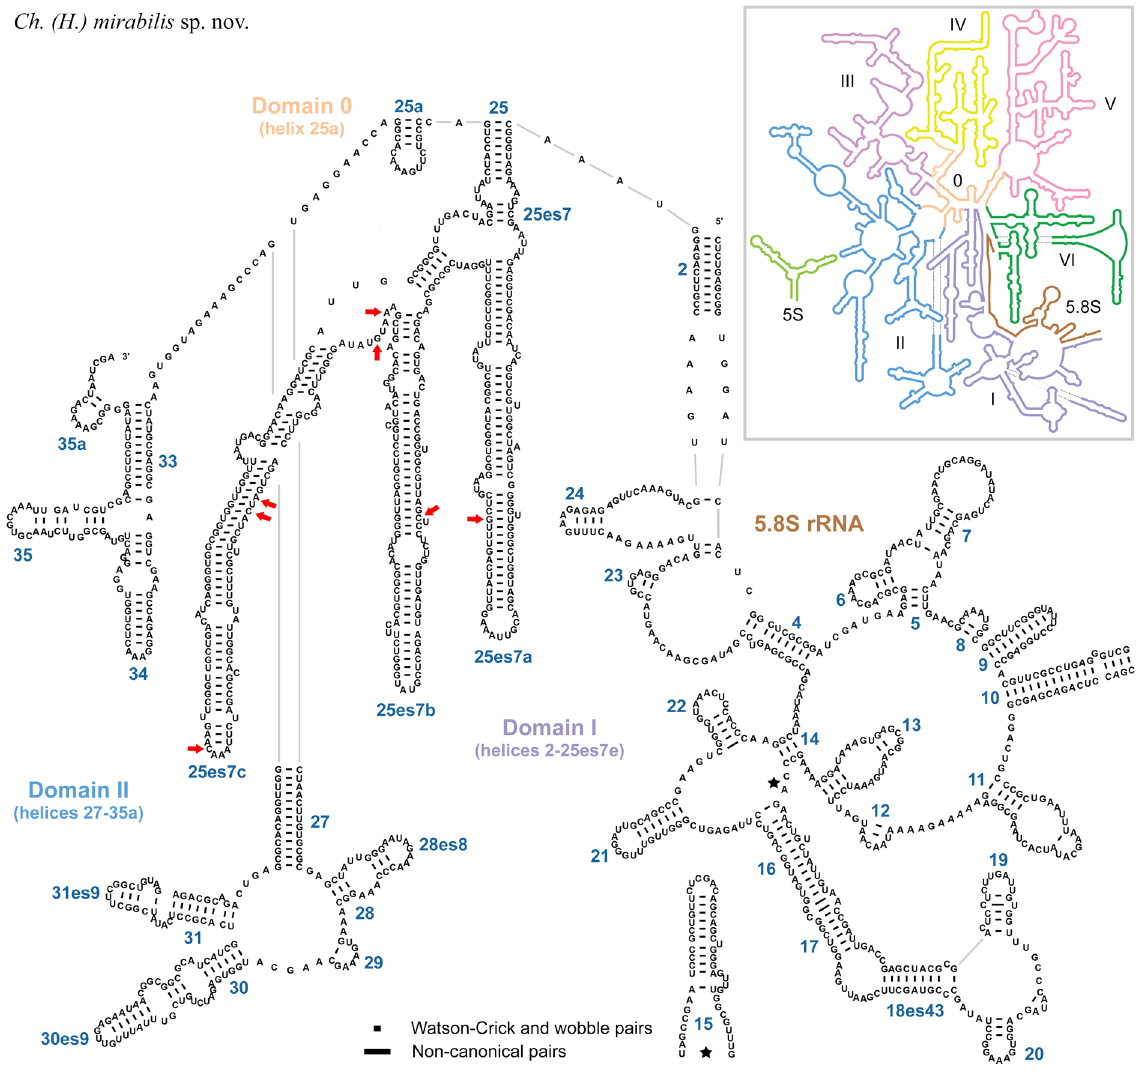
Fig. 7. Secondary structure of the first two domains of the 5.8‒28S rRNA molecule of Chaetonotus ( Hystricochaetonotus ) mirabilis sp. nov. Diagnostic molecular autapomorphies are marked by red arrows. The reference 28S secondary structure map of Saccharomyces cerevisiae Meyen ex E.C.Hansen (inset) is from http://apollo.chemistry.gatech.edu/RibosomeGallery (Petrov et al.